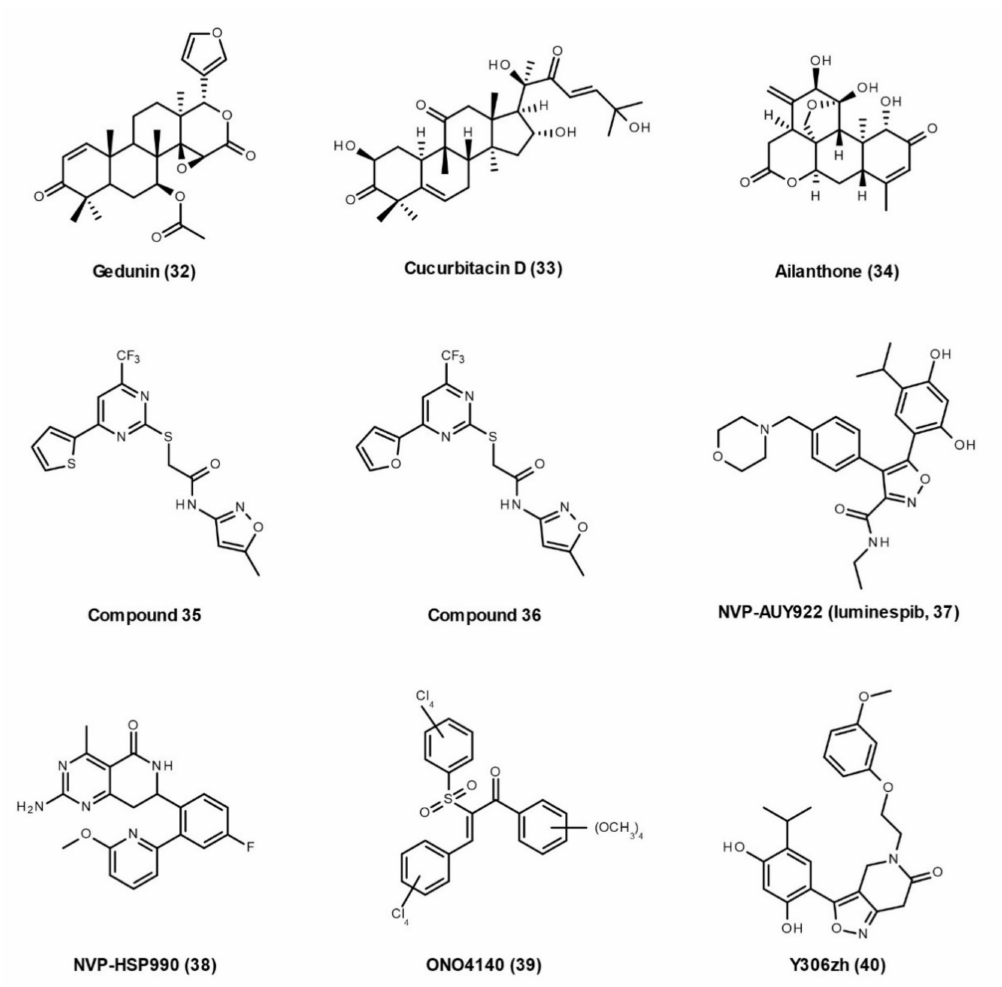
Figure 7. Developed small molecules with the ability to disrupt Hsp90–p23